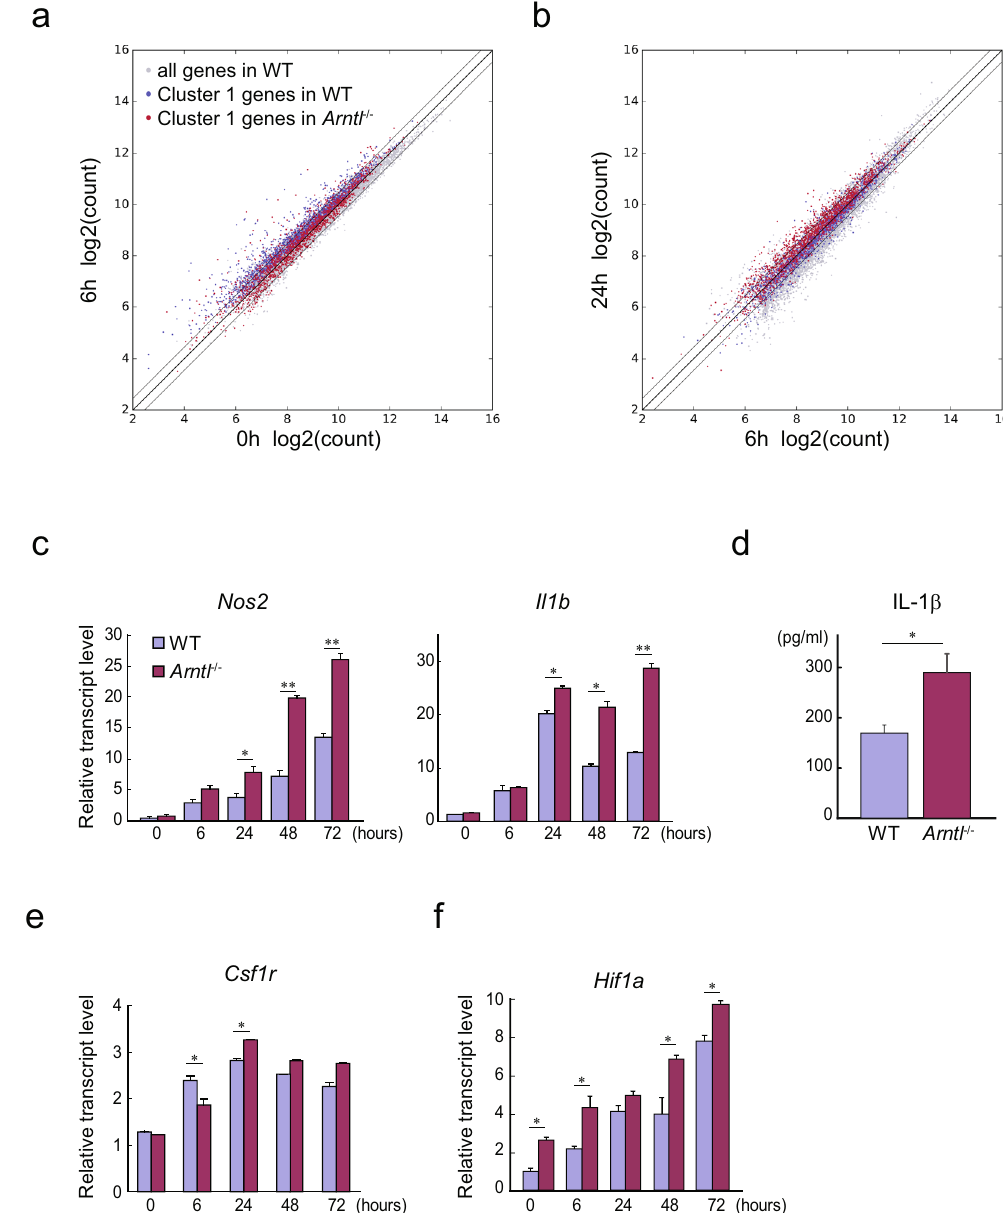
Figure 2. Prolonged inflammatory response in Arntl − / − macrophages. ( a , b ) Scatter plots depicting the relationship between log2 normalized counts of cluster 1 genes in WT and Arntl − / − macrophages treated with KLA for 0 or 6 h ( a ) and 6 or 24 h ( b ). Gray dots indicate all RefSeq genes with counts ≥ 100 at one or more time points in WT macrophages. Blue and red dots represent the genes belonging to cluster 1 in WT and Arntl − / − macrophages, respectively. Lines indicating a 1.5-fold change are shown. ( c ) Relative mRNA expression of Nos2 and Il1b in WT and Arntl − / − macrophages treated with KLA for the indicated times. n = 3 for each group at each time point. ( d ) Levels of IL-1 β protein in the culture media of WT and Arntl − / − BMDMs stimulated with KLA plus ATP. n = 10 for each group. ( e , f ) Relative mRNA expression of Csf1r ( e ) and Hif1a ( f ) in WT and Arntl − / − macrophages treated with KLA for the indicated times. n = 3 for each group at each time point. For qPCR in ( c , e and f ) expression levels were first normalized to those of 18 s rRNA and then further normalized to the levels in WT cells at 0 h. * p < 0.05, ** p < 0.01 between WT and Arntl − / − cells at the same time